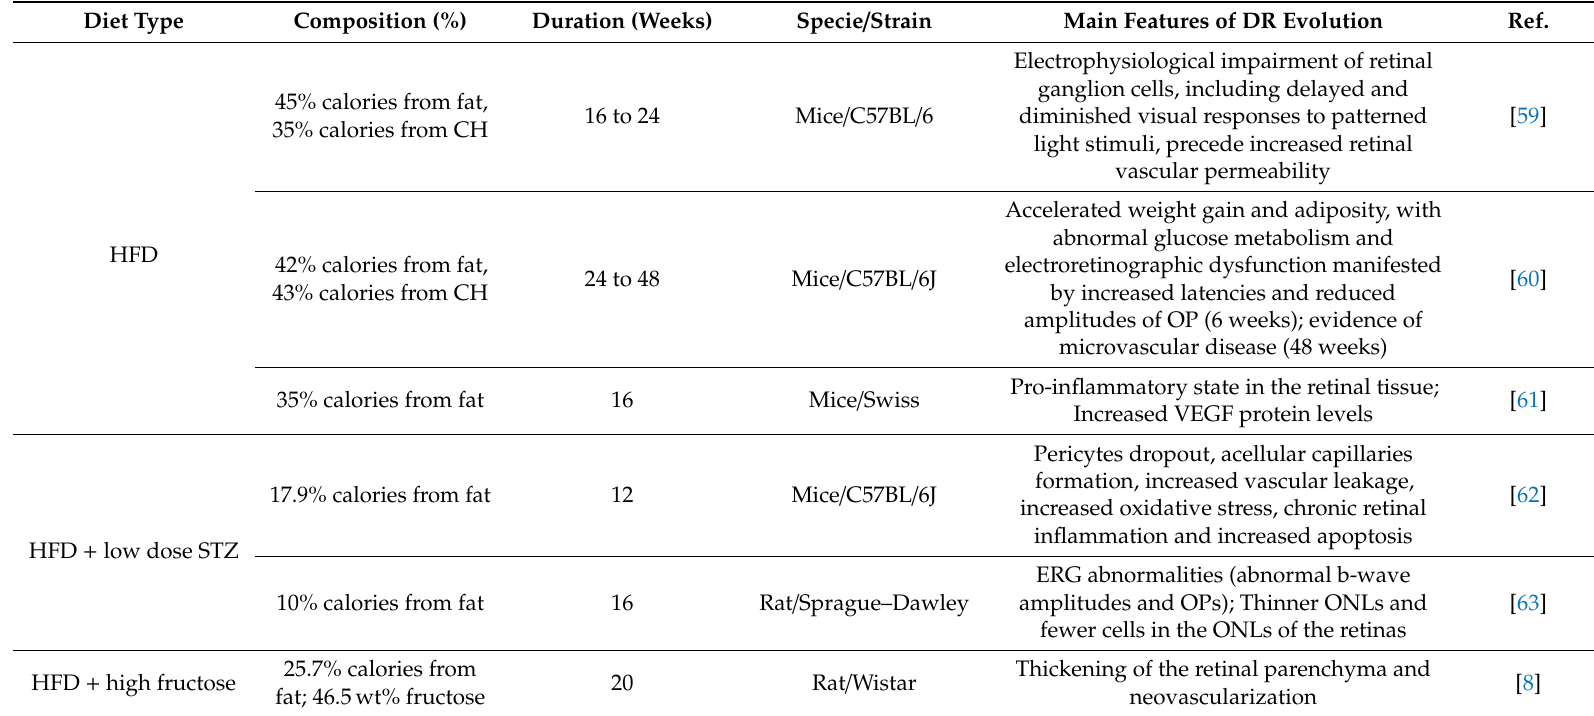
Table 2. Main features of diet-induced rodent models of diabetic